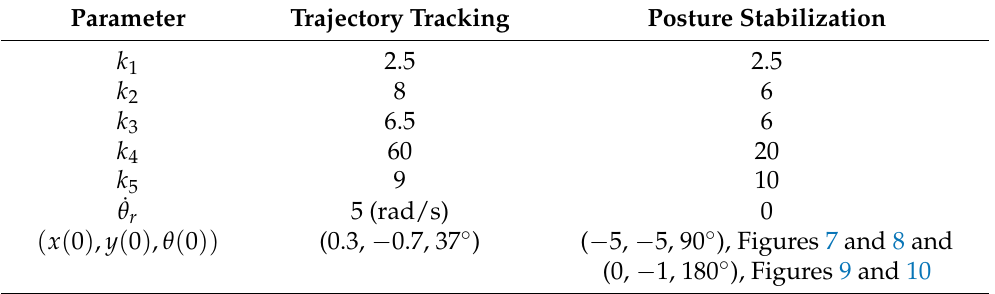
Table 2. Controller parameters.